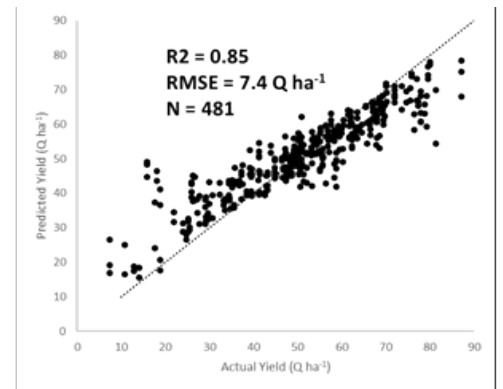
Table 5 Result of Random forest prediction for four cases